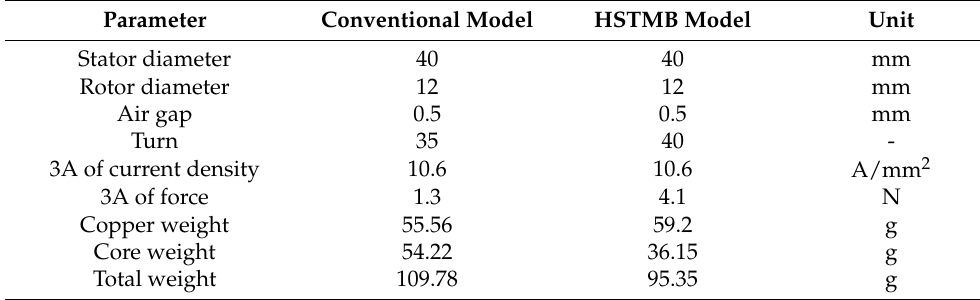
Figure 16. Force–current stiffness and the force in the HSTMB. Table 3. Comparison of Conventional model and HSTMB model